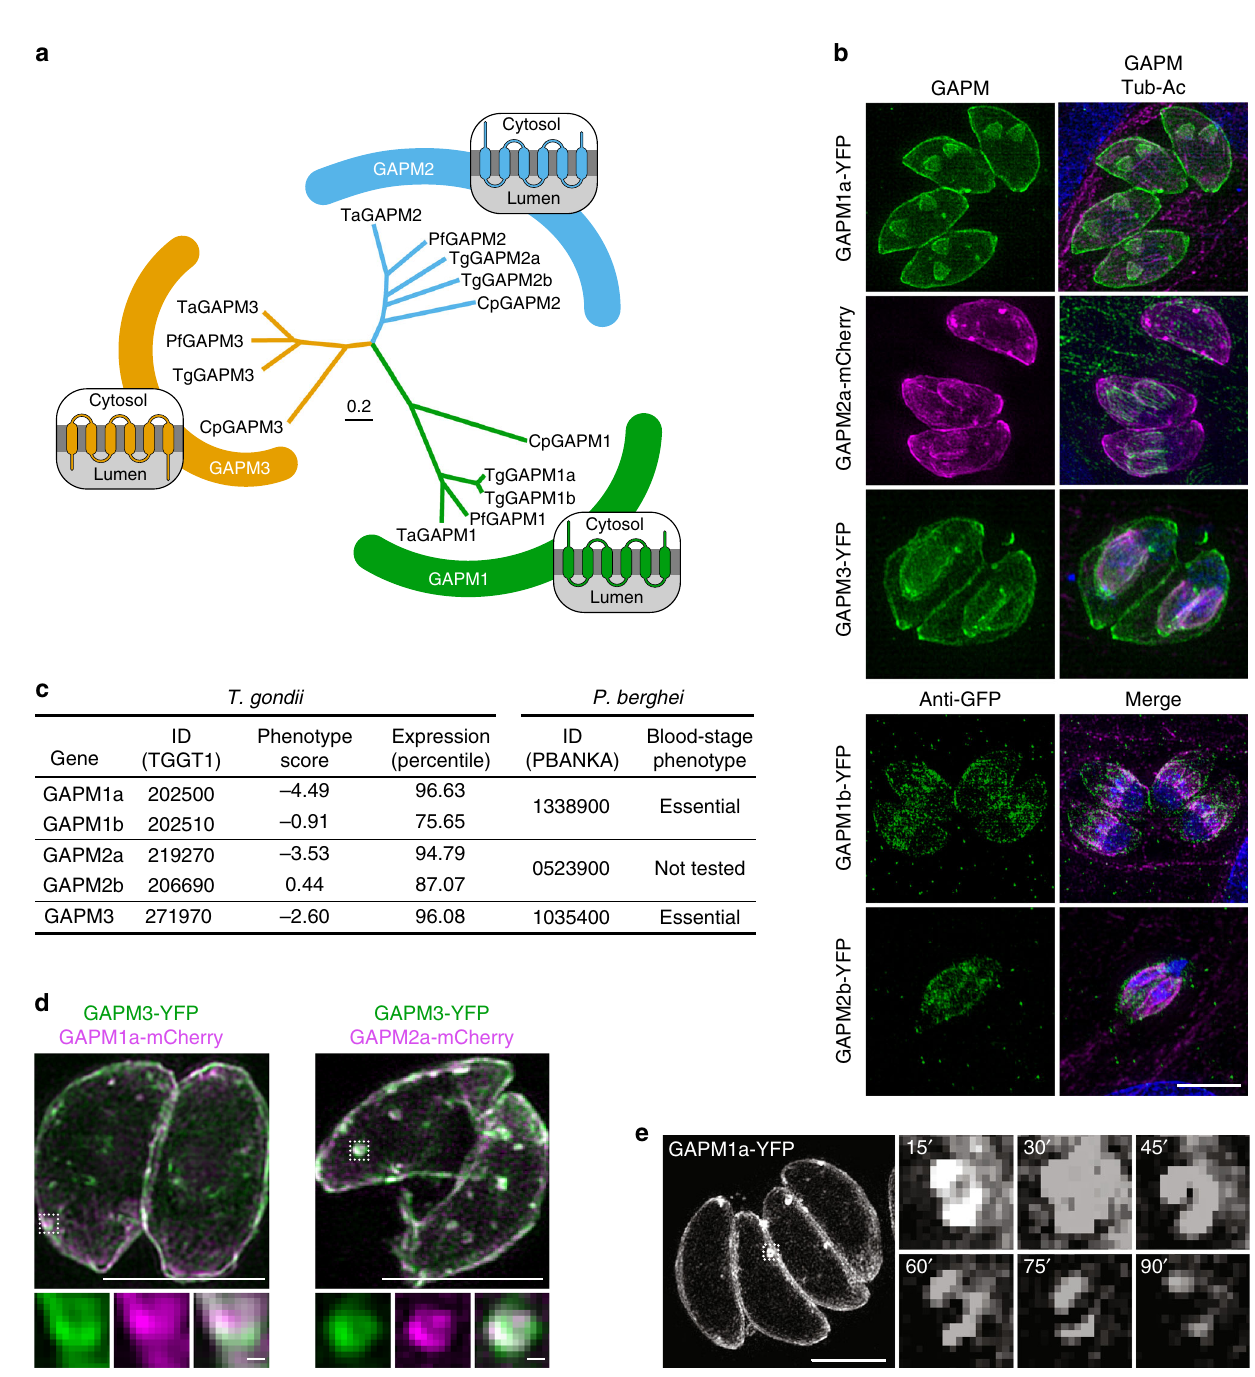
Fig. 1 GAPM proteins localise to the IMC and are enriched at ring-like structures. a Cladogram of the GAPM proteins conserved among apicomplexans. Predicted membrane topology for each clade is illustrated 30 . b Table of GAPM genes, their transcriptional expression, and their importance for tachyzoite- stage T. gondii 31 and blood-stage P. berghei 32 . c GAPM proteins were C-terminally tagged with YFP or mCherry and visualised by SR-SIM in relation to acetylated tubulin. Projections of z-stacks of dividing cells are shown. GAPM1b-YFP and GAPM2b-YFP were expressed at a low level and therefore visualised indirectly with antibodies against GFP. All proteins were localised to the IMC in both mature and dividing cells. d Endogenously tagged GAPM proteins co-localise throughout the IMC and at ring structures (detail). Detail scale bar is 100 nm. e Live-cell SR-SIM of GAPM1a-YFP. Z-stacks were acquired every 7 min and projected to show fi xed ring structures within the IMC that do not change in size or position over the course of 90 min. Images are representative of three independent experiments. Detail scale bar is 500 nm. Unspeci fi ed scale bars are 5 μ